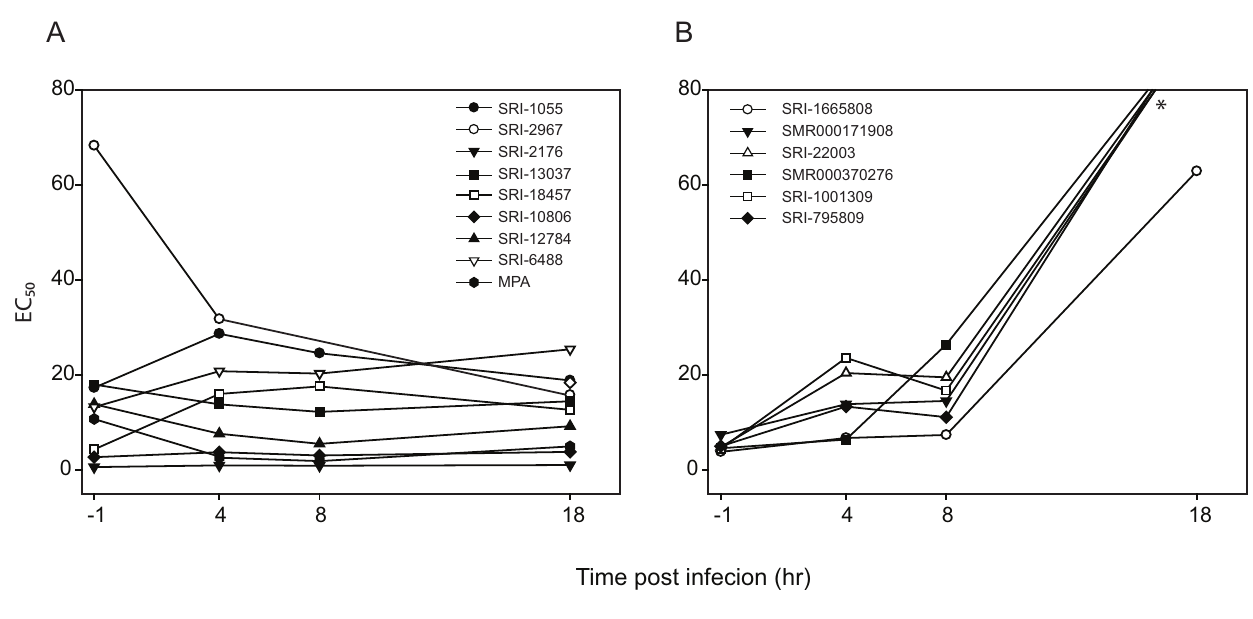
Figure 3. Examples of changes in EC assay in 384-well format was executed for each time point and the EC described in the text. (A) Compounds failed to exhibit significant change in EC 18 h post-infection. Meanwhile, the other compounds showed sudden increase in EC between 8 and 18 h post-infection (B). * EC graphical purpose, the lines were extended beyond border of graph.